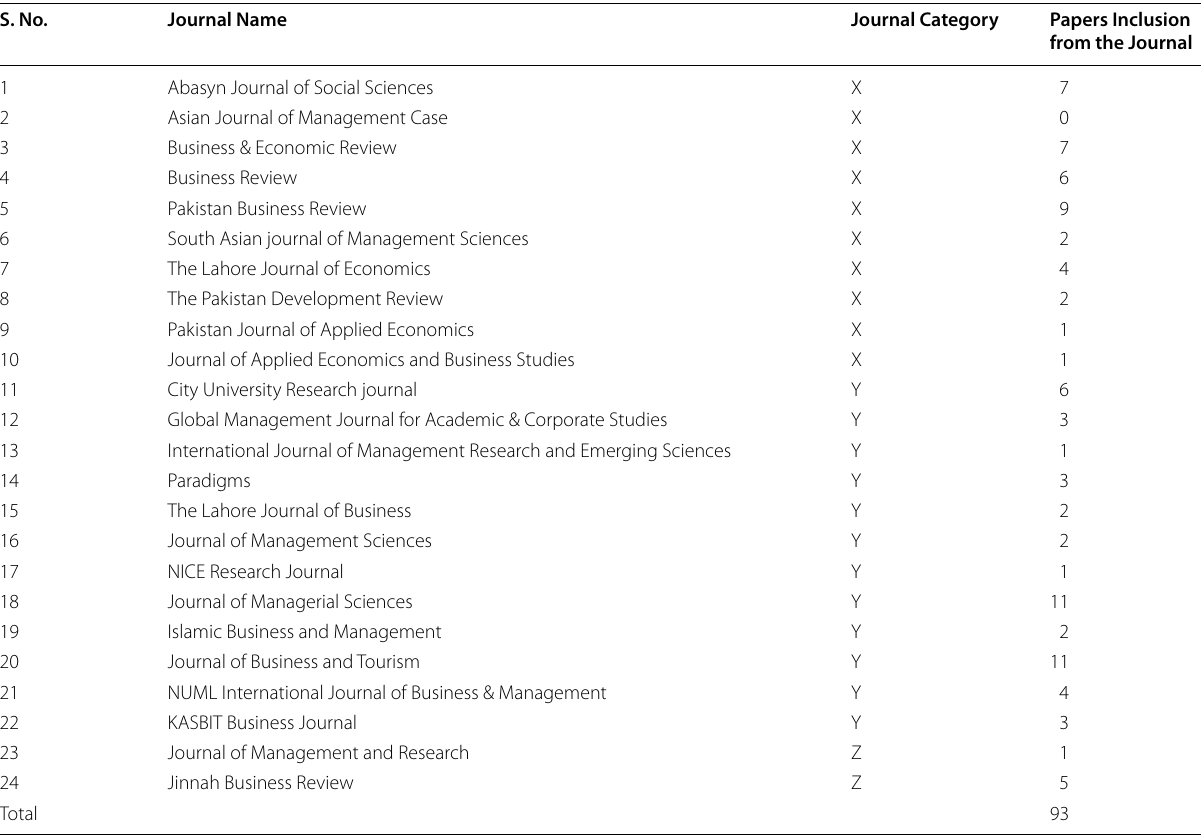
Table 2 HEC Recognized National Research Journals of Management Sciences & Economics List and Papers Taken for this Study S.